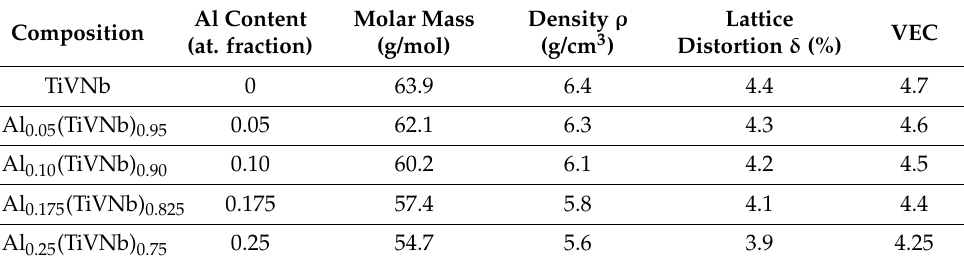
Table 1. Physicochemical (molar mass and bulk density) and empirical parameters (lattice distortion and VEC) of the Al x (TiVNb) 1 − x (x = 0 [17], 0.05, 0.10 [17], 0.175, 0.25) alloys. Al Content Molar Mass Density ρ Composition (at. fraction) (g/mol) TiVNb Al 0.05 (TiVNb) 0.95 Al 0.10 (TiVNb) 0.90 Al 0.175 (TiVNb)